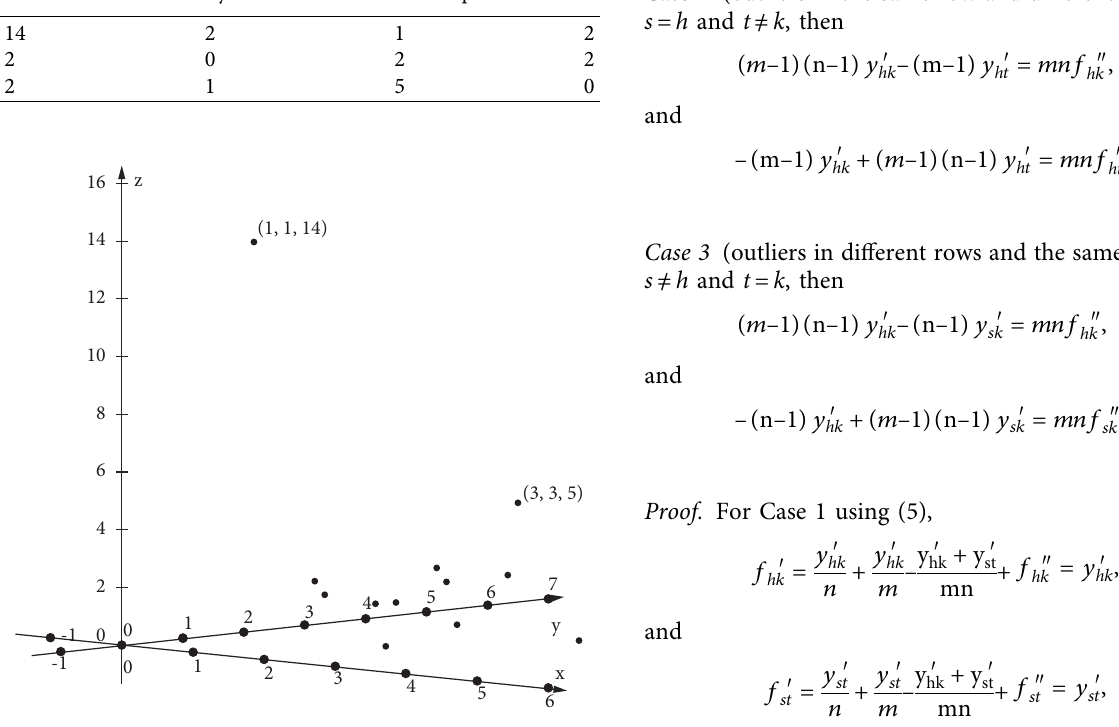
Table 1: Tukey’s artifcial data for Example 1.